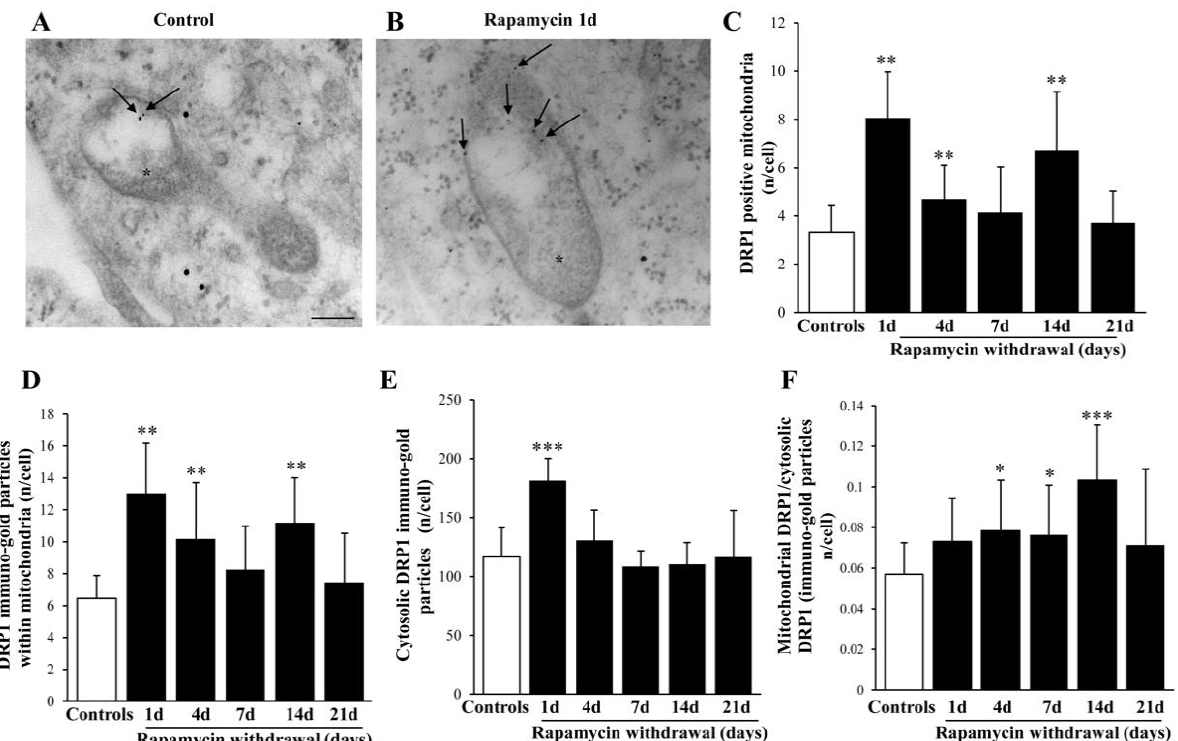
Int. J. Mol. Sci. 2021 , 22 , x FOR PEER REVIEW 14 of 23 Figure 12. Representative immuno-gold and polarization graphs for the mitochondrial fission marker DRP1. Representative TEM micrograph showing DRP1-positive mitochondria from control ( A ) and following 1 d rapamycin withdrawal ( B ). Arrows point to DIRP1 immuno-gold particles within mitochondria. Graphs report the DRP1-positive mitochondria ( C ), DRP1 immuno-gold particles within mitochondria ( D ), the cytosolic amount of DRP1 ( E ), and the ratio of mitochondrial to cytosolic DRP1 particles ( F ). Values reported in the graph correspond to the mean ± SD. Mitochondria were counted in 50 cells per group. * p ≤ 0.05 compared with controls. ** p ≤ 0.05 compared with controls and 21 d. *** p ≤ 0.05 compared with other groups. Scale Bar = 0.5 µ m, Asterisk (*) = mitochondria.